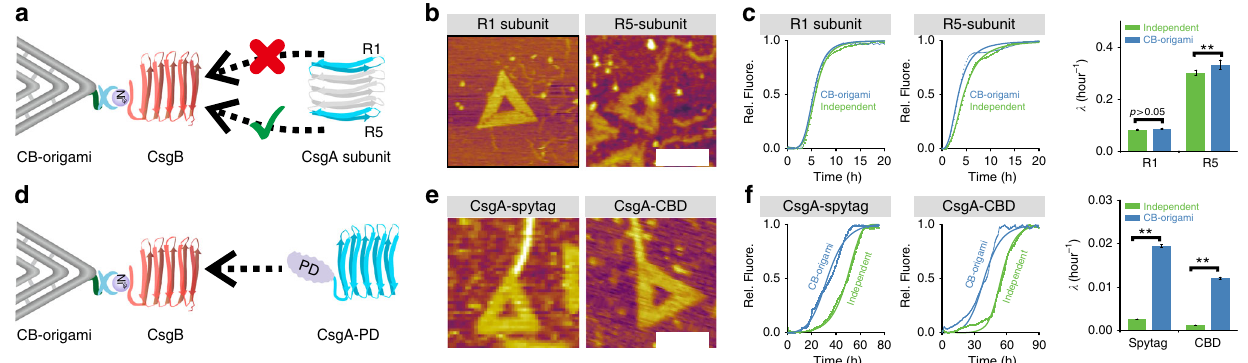
Fig. 5 Directional polymerization of CsgA subunit and derivatives with CB-origami. a – c Nucleation-directed polymerization of CsgA subunits with CB- origami: a schematic showing CB-origami-directed polymerization of CsgA subunit, R1 and R5 domain, b Corresponding AFM height images of the assembled structures, c Representative ThT curves and kinetic rate constant comparison; d – f Nucleation-directed polymerization of functional CsgA proteins with CB origami: d schematic showing CB-origami-directed polymerization of CsgA-PD (PD, Peptide domain or Protein domain) proteins, CsgA- spytag and CsgA-CBD, e AFM height images of the assembled structures, showing that fusion domains did not block the nucleation effect of CsgB, f Representative ThT curves and kinetic rate constant comparison. Note: For all the ThT curves and kinetic constant comparison in c and f , green and blue curve/bar chart refers to independent polymerization and polymerization in the presence of CB-origami, respectively. λ refers to the proliferation rate of primary pathways and presented as the mean ± s.e.m. based on three independent experiments ( n = 3). ** P < 0.01, two-tailed two-sample t -test. Scale bars: 100 nm. Note: AFM imaging was purposely carried out in tapping mode in liquid. Source data are provided as a Source Data fi